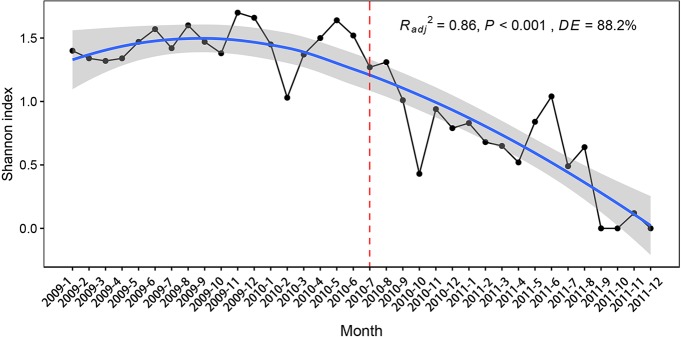
The Shannon diversity species index of the submerged plants in 2009, 2010, and 2011.